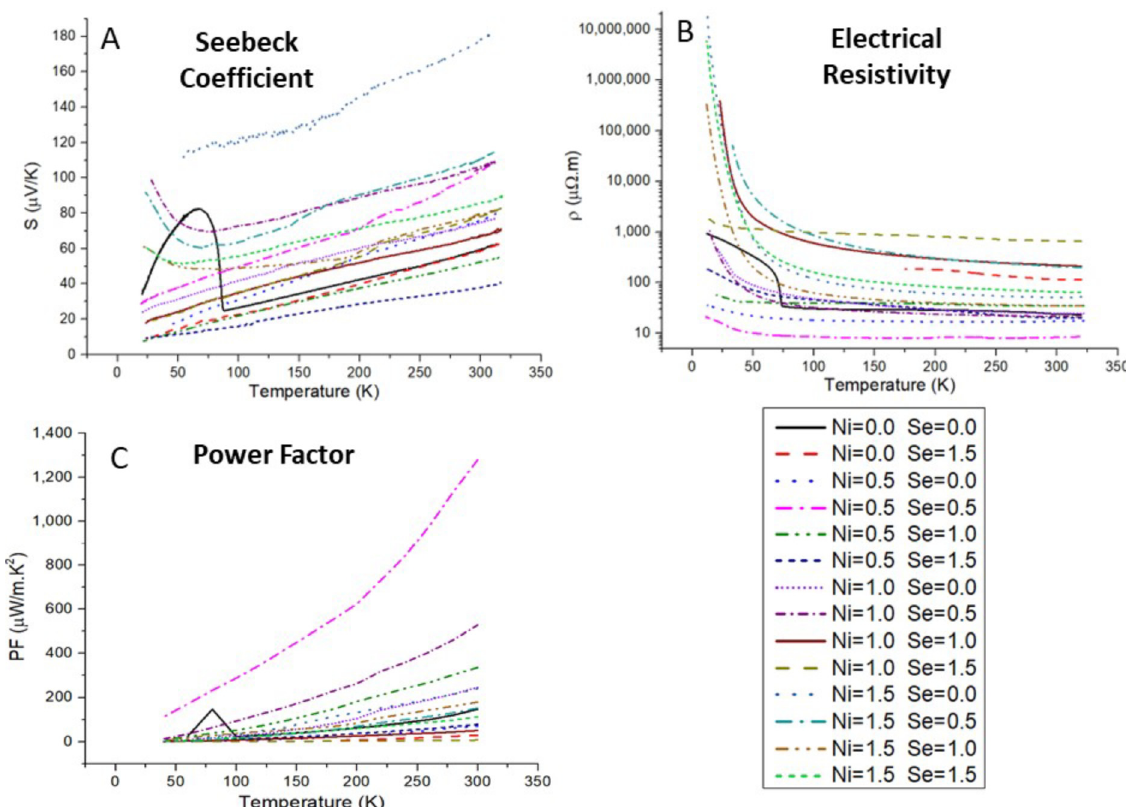
Figure 8. Measured temperature dependence of electrical resistivity, ( A ) and Seebeck coefficient, S ( B ); and resulting power factor, PF, as a function of temperature ( C ), calculated for the Cu 12 − x Ni x Sb 4 S 13 − y Se y samples.